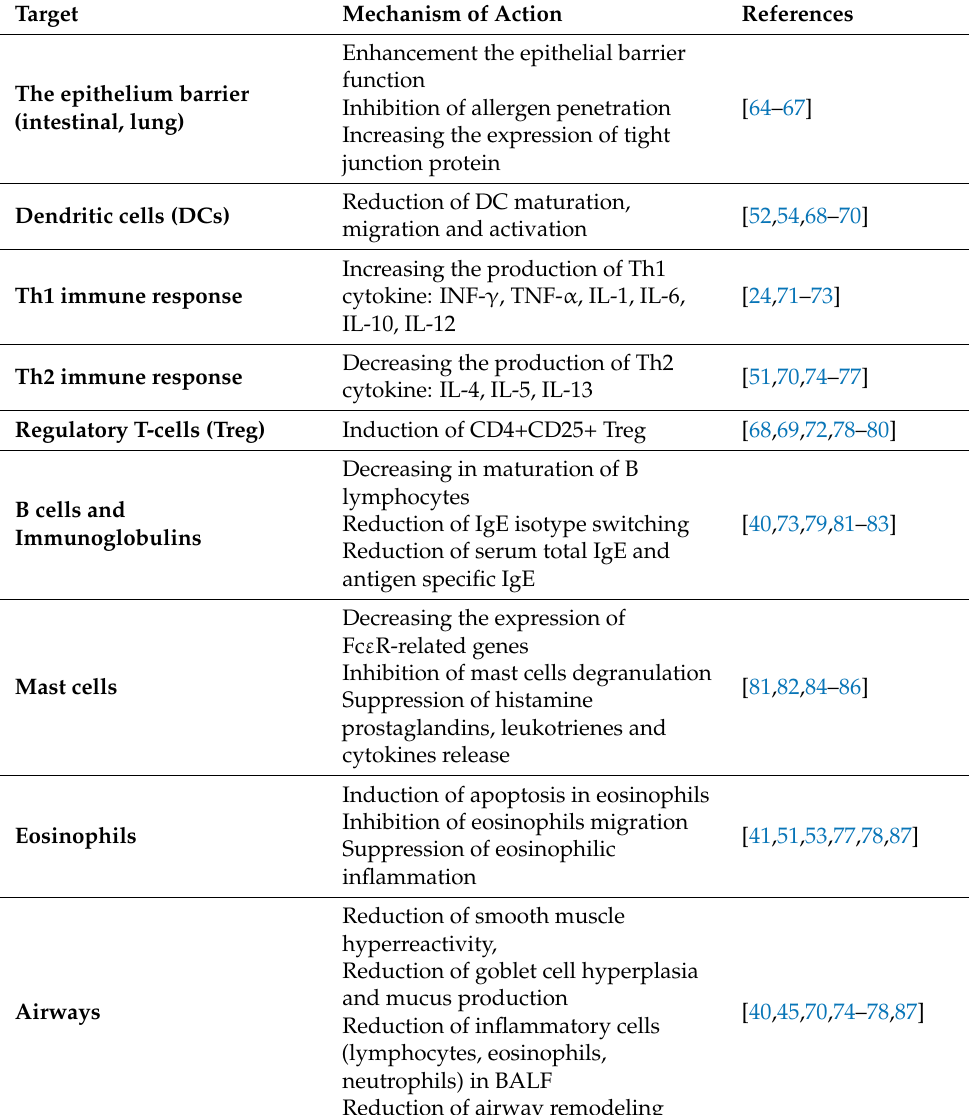
Table 3. Proposed mechanisms of immunomodulatory action of fermented